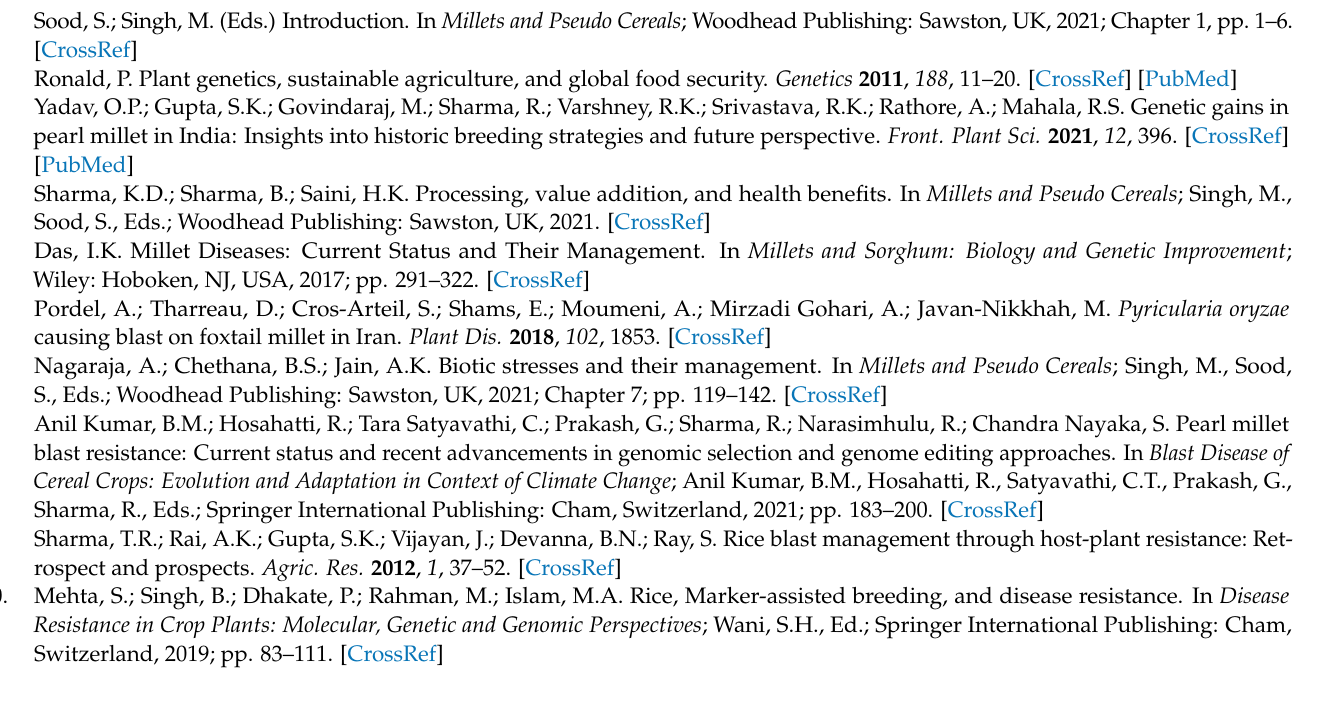
and M. oryzae NI907 genomes. Table S10: The mapped PFAM in the secretome featured sequences classification against the PFAM database. Table S11: The mapped CAZyme features in the secretome sequences classification against CAZymes (dbCAn2) database. Table S12: The mapped PFAM features in the peptidase sequences classification against the MEROPS database. Table S13: Effector proteins with CAZyme features. Figure S1: Plate morphology and spore structure of M. grisea PMg_Dl. Figure S2: Functional annotation of predicted genes/proteins of M. grisea PMg_Dl in GO terms: (a) biological process-related GO groups, (b) molecular function-related GO groups, (c) cellular component-related GO